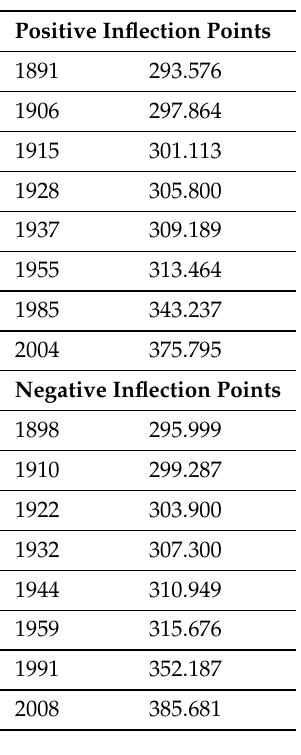
Figure 6. Heat content: in 1943 where CO 2 had a local maximum ( Left ); in 1946 where CO 2 had a local minimum ( Right ). The temperature anomalies are represented within a range from -2 degrees Celsius (dark blue) to +2 degrees Celsius (dark orange). Table 4. Positive and negative inflection points of CO 2 concentration between 1880 and